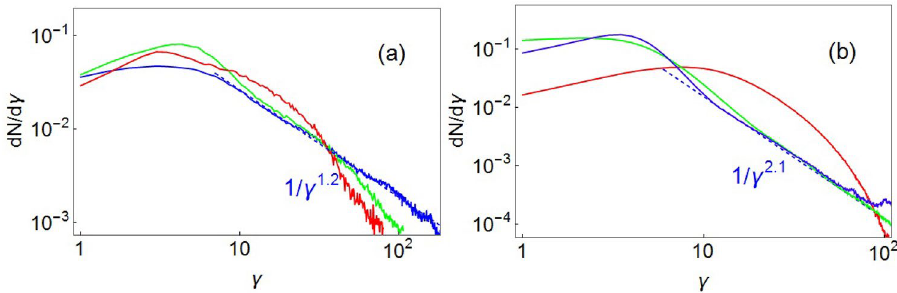
Figure 4. ( a ) Evolution of energy spectrum averaged over longitudinal and transverse size of MV for ω pe t = 1038 (red), 1178 (green) and 1204 (blue) and corresponding power-law fits (dashed line), ( dN / d γ 1.2 . ( b ) Evolution of energy spectrum for the entire upstream region for ω p ≈ 1233 (blue) and corresponding fit (with power index p